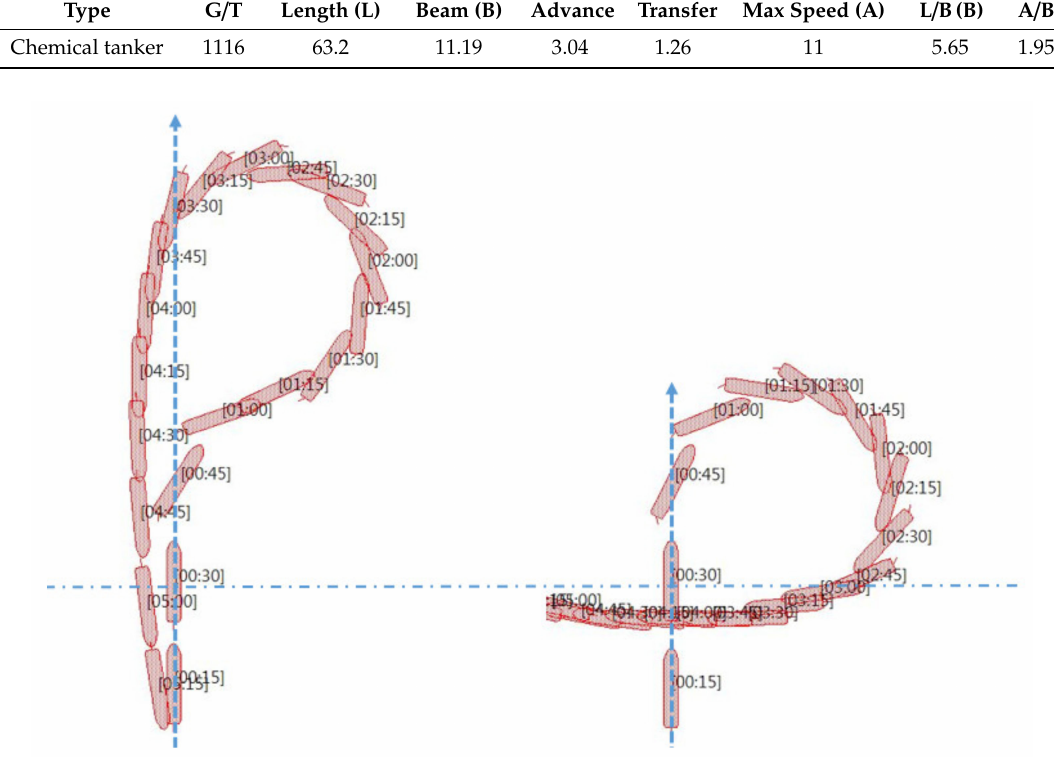
Figure 5. Williamson turn ( left ), Anderson turn ( right